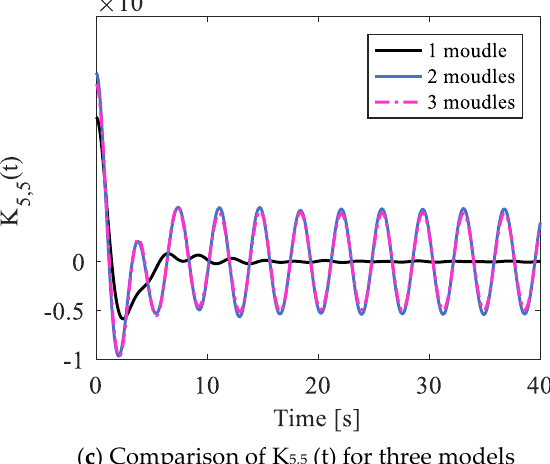
( b ) Comparison of K 3,3 (t) for different artificial damping